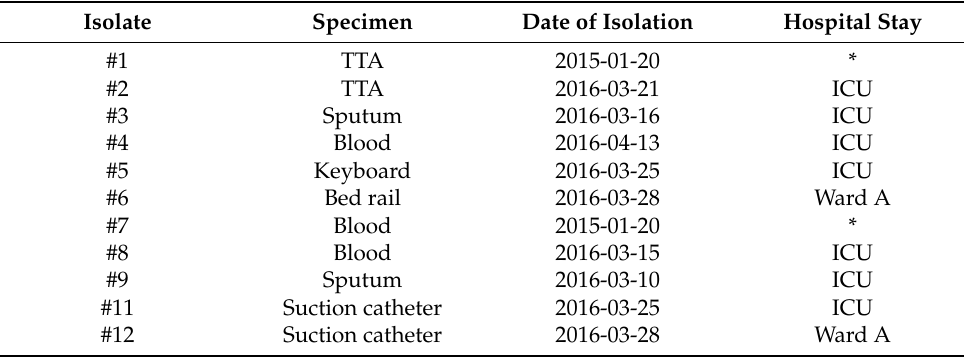
Table 1. Clinical information of A. baumannii isolates included in this study. Isolate Specimen Date of